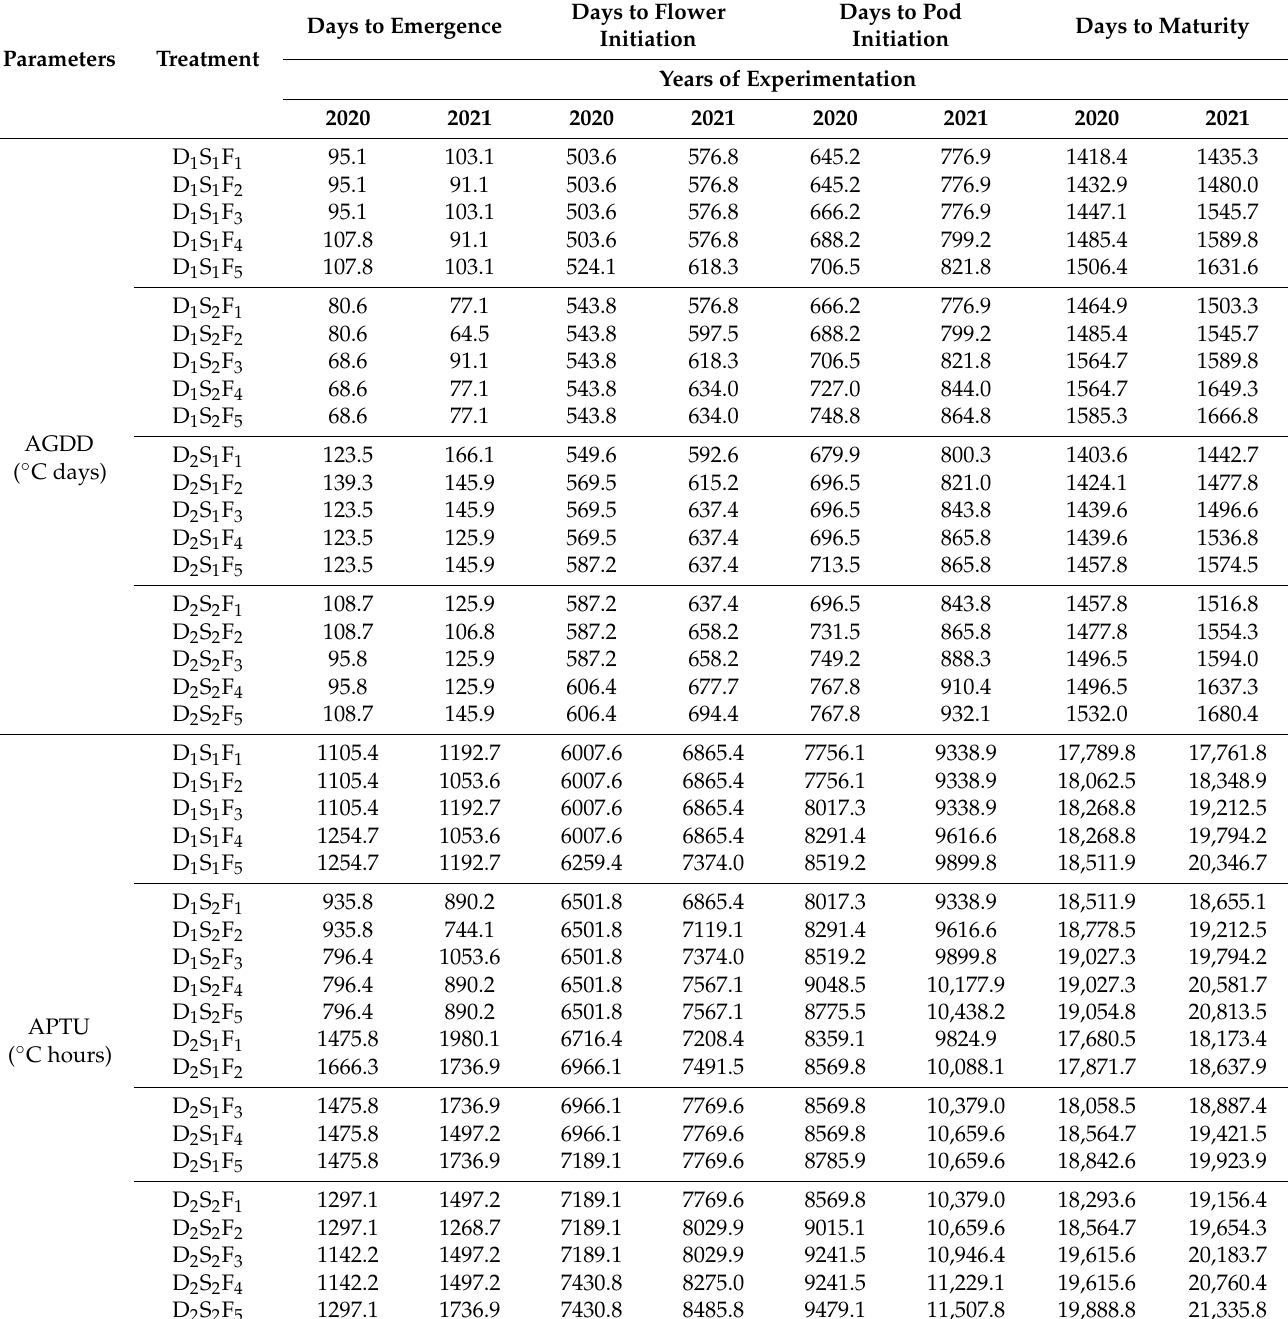
Table 7. Requirements of accumulated GDD, PTU and HTU of black gram at different phenophases. Days to Days to Emergence Parameters Treatment